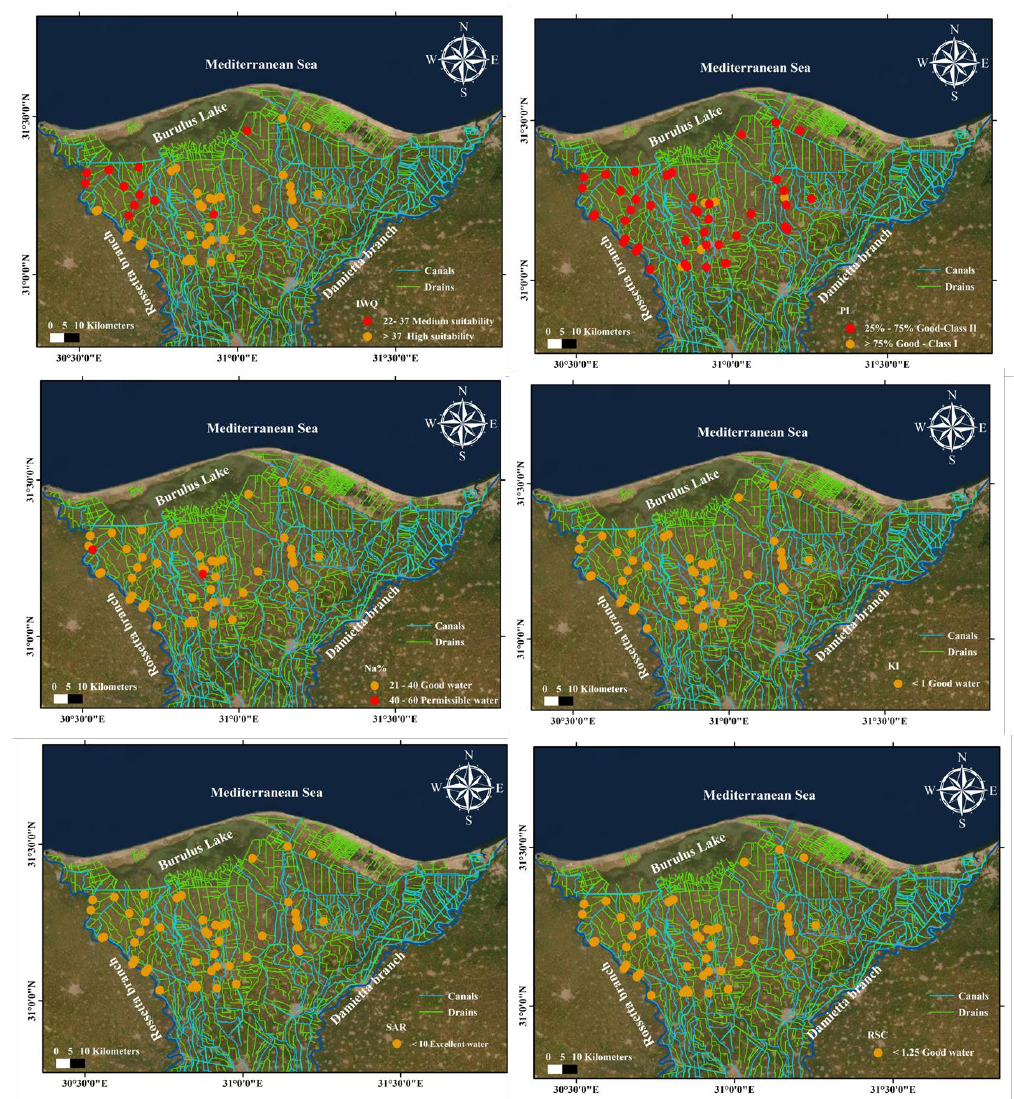
Figure 6. Spatial variation maps of Irrigation Water Quality Indices in year 2019.